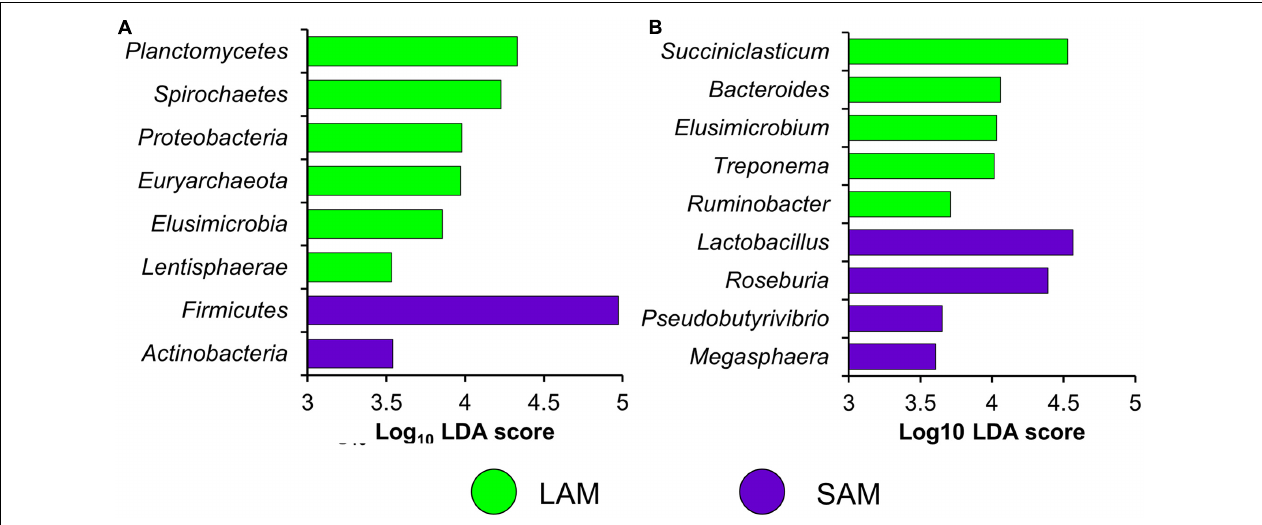
FIGURE 6 | Differentially abundant (A) phyla and (B) genera between LAM and SAM samples as determined using linear discriminant analysis effect size (LEfSe) analysis. Only phyla and genera with a LDA score > 3.5 and an overall relative abundance of > 0.01% are included.